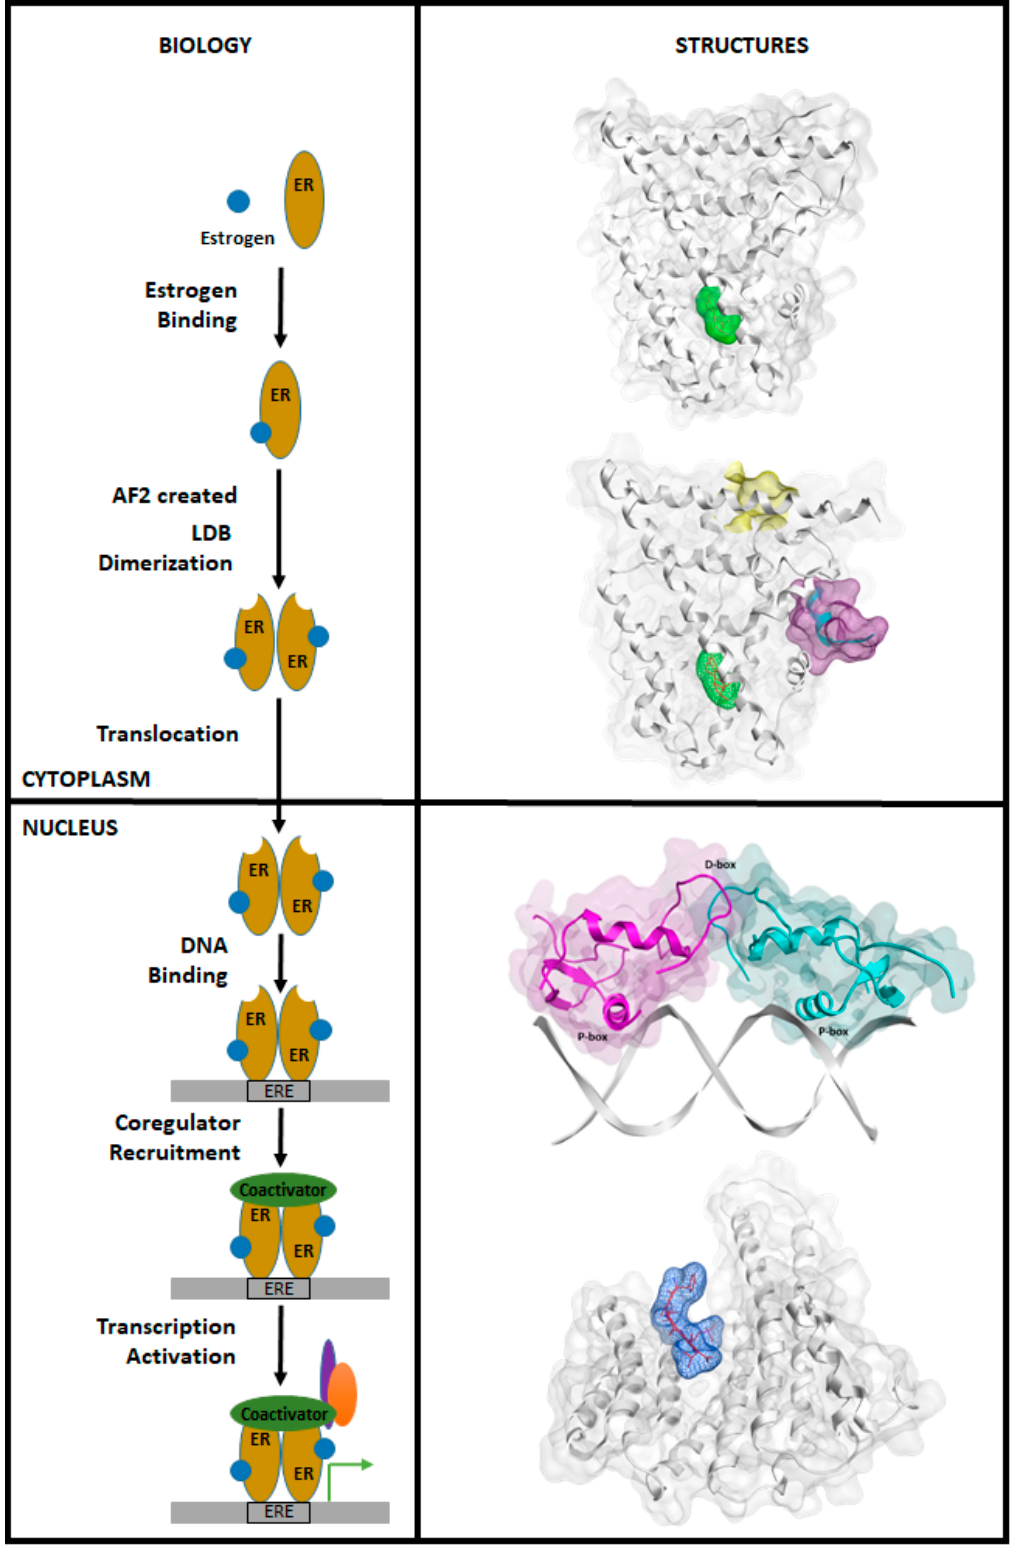
Figure 4. The biology of classic ER transcriptional mechanism (left) with the corresponding structures (right): the first structure depicts E2 (green) bound to the ER-LBD; the second structure depicts an E2 (green) activated ER with an coactivator docked to the created AF-2 site (purple) along with the potential dynamic BF3 site (yellow); the third structure shows a translocated DBD/DBD ER dimer bound to DNA; and the fourth structure shows the F-domain bound to an AF-1 mediated transcription repressor protein, 14-3-3 (white).